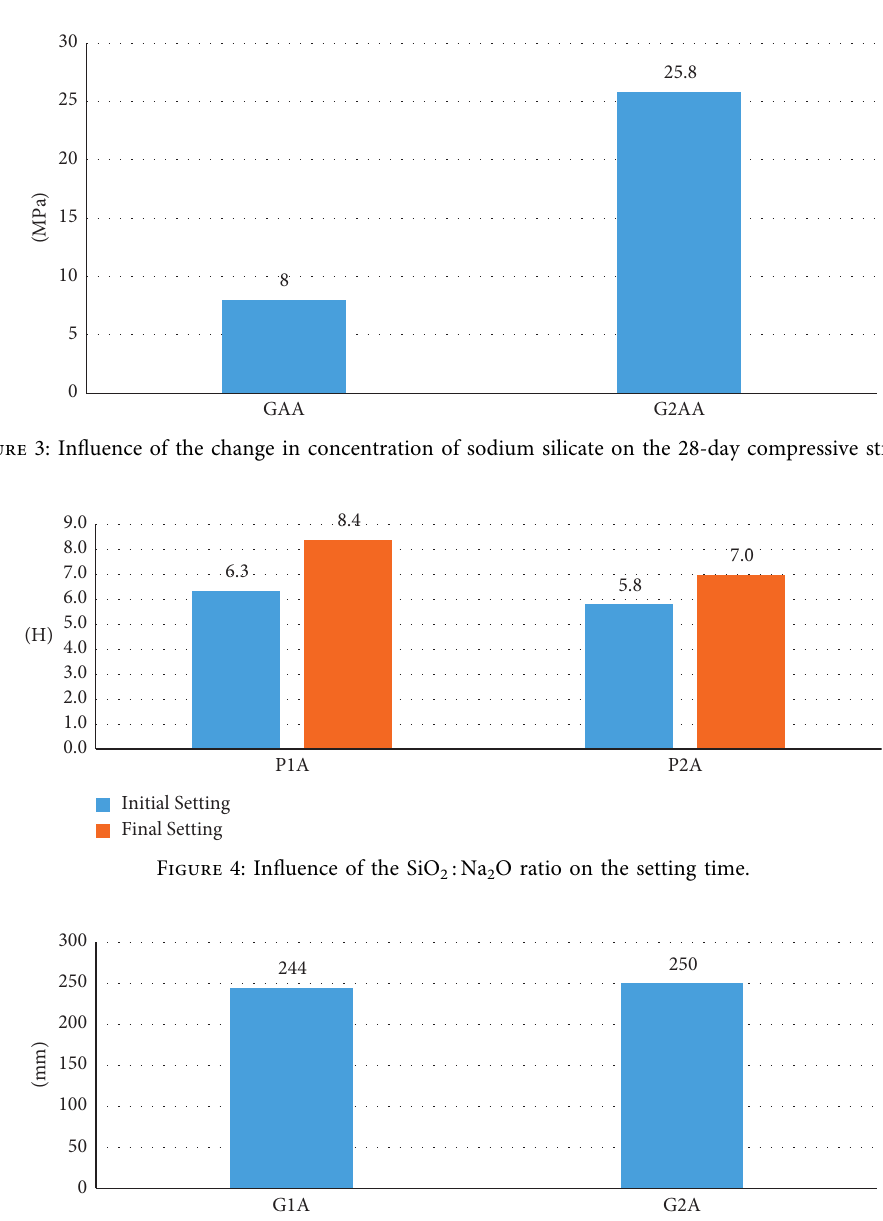
Figure 5: Influence of the SiO 2 :Na 2 O ratio on the flowability.